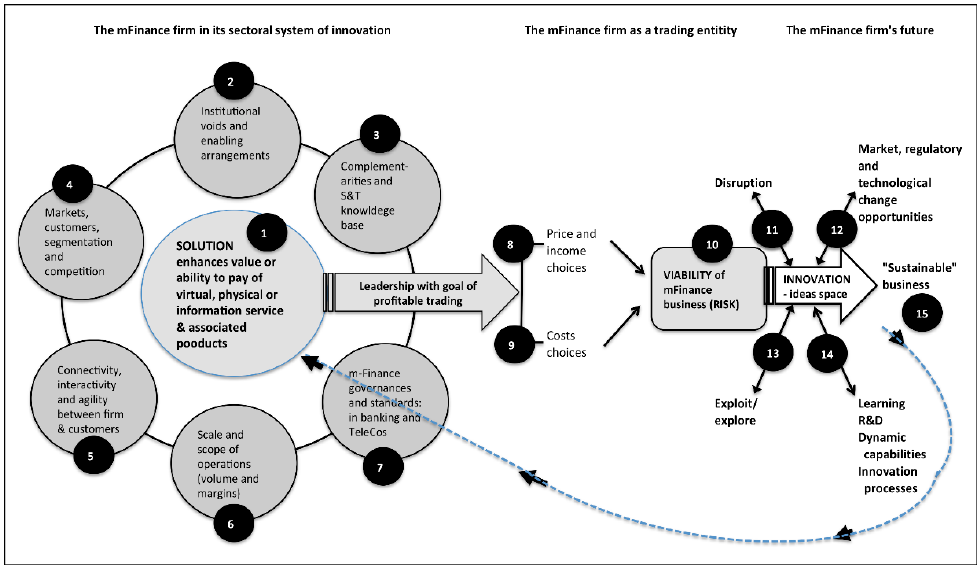
Figure 4. The m-payments firm trading in a SSI. Table 1. Fifteen variables in analytical framework.